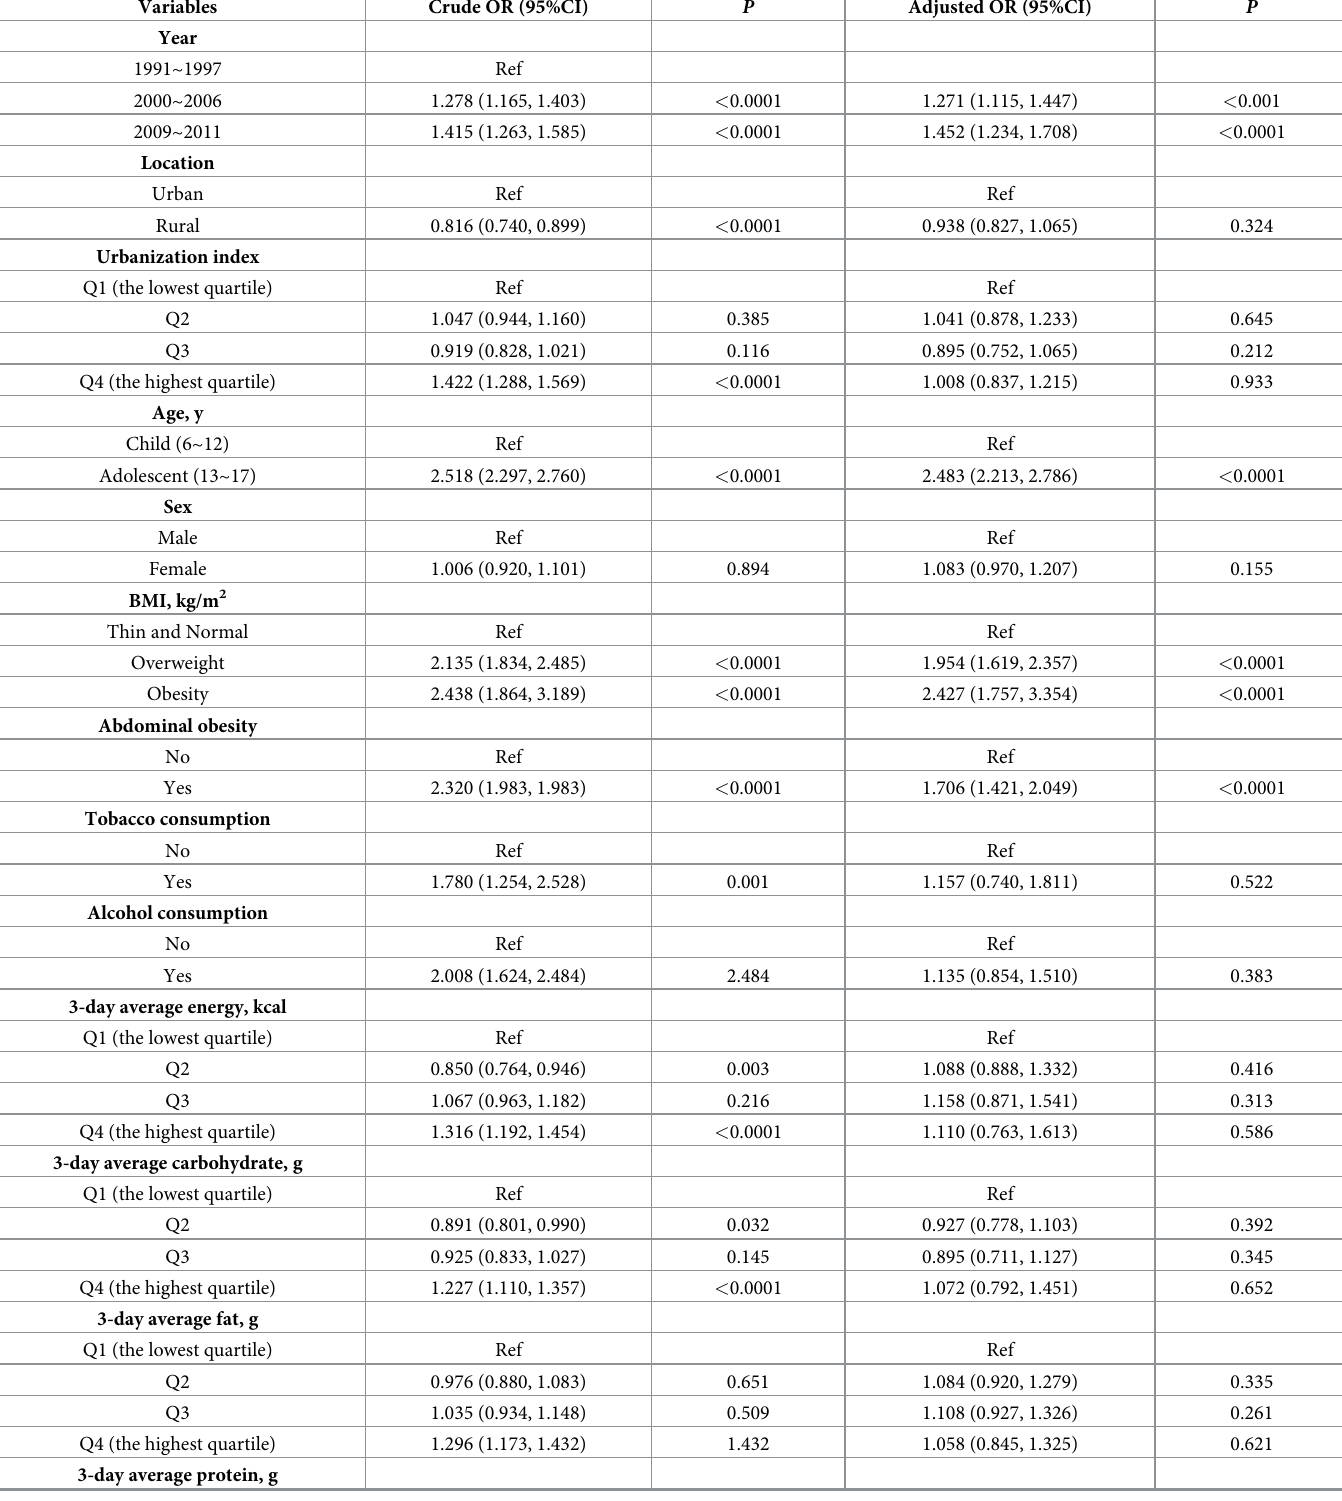
Table 2. Factors associated with prehypertension and